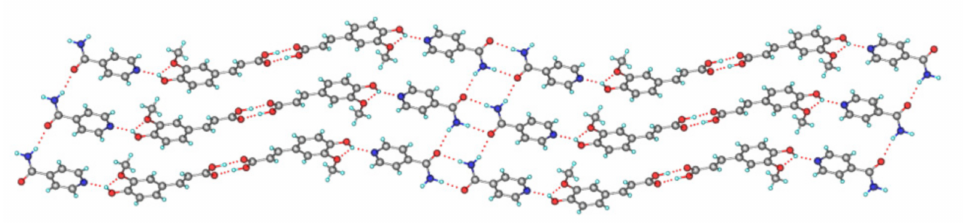
Figure 12. Crystal packing of FA-INA cocrystal showing hydrogen-bonded sheet structure mediated by acid–acid and amide–amide homosynthons and hydroxyl-pyridine heterosynthon [100] (With permission from [100]; Copyright 2020